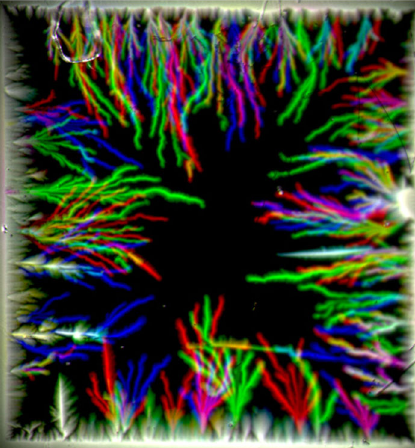
FIG. 7. Superposition of three magneto-optical images (red, green, and blue) taken at the same applied field, B a ¼ 22 mT at T ¼ 9 : 2 K in three different experimental runs. The presence of colors shows that the dendritic avalanches are irreproducible. The sample is a 5 (cid:3) 5 mm 2 , 300-nm-thick film of MgB ð 1(cid:2)102 Þ O Al 2 3